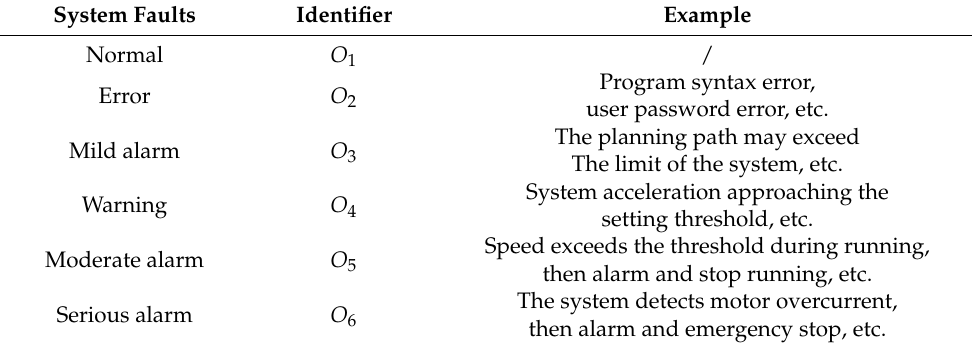
Figure 5. The analysis diagram of security and system fault. Table 5. Example of system